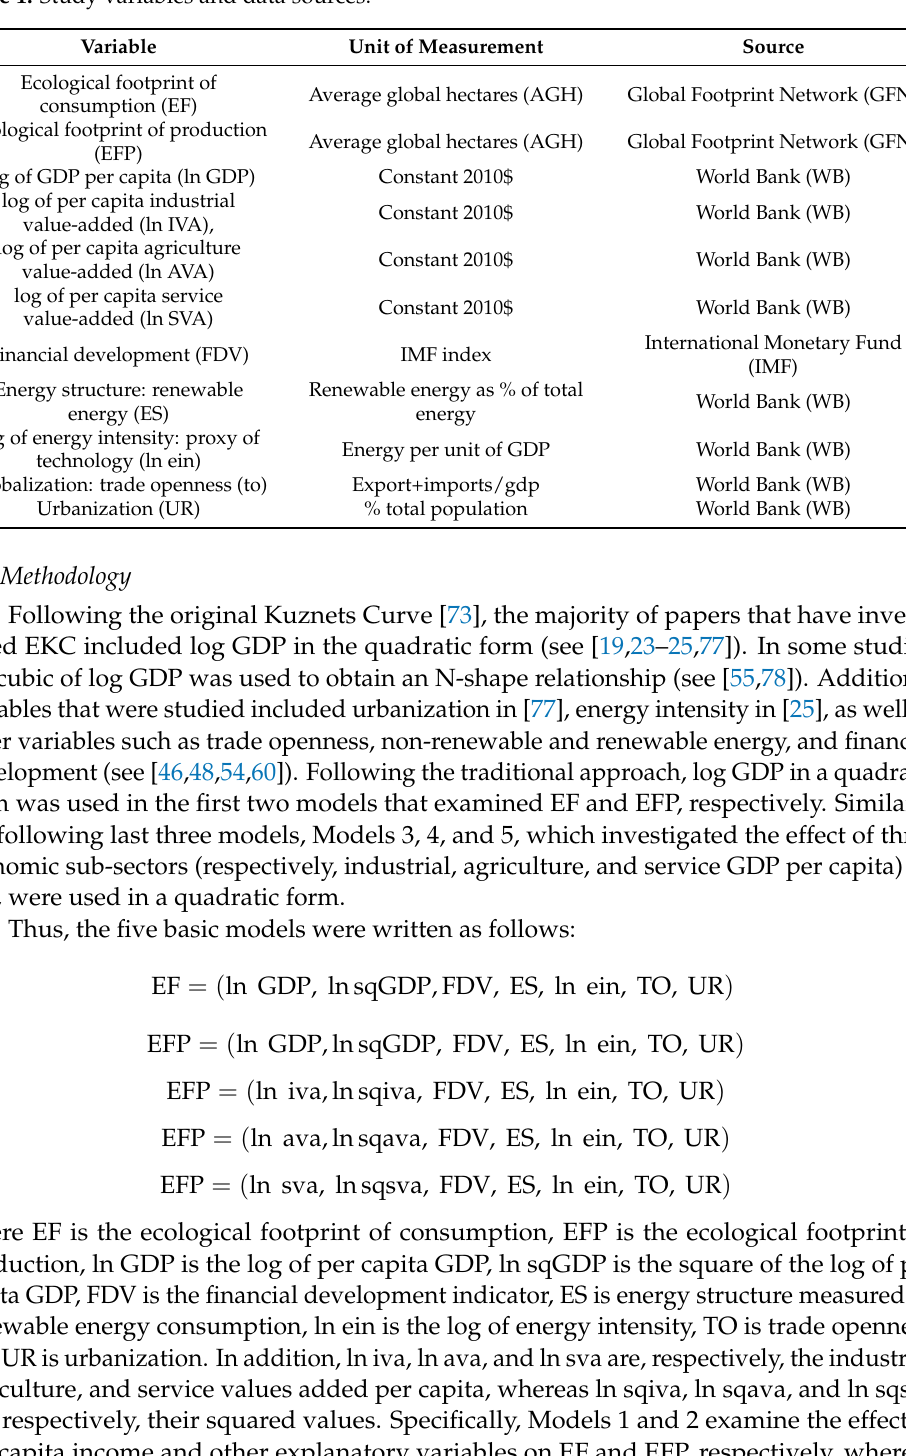
Table 1. Study variables and data